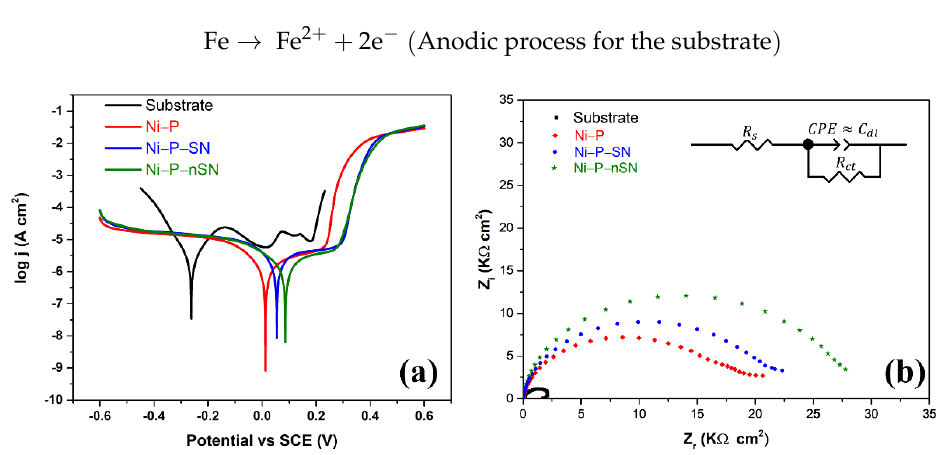
Figure 7. ( a ) Tafel and ( b ) Nyquist curves of the substrate and coating specimens. The inset in ( b ) shows the equivalent circuit diagram for the Nyquist curve fittings.